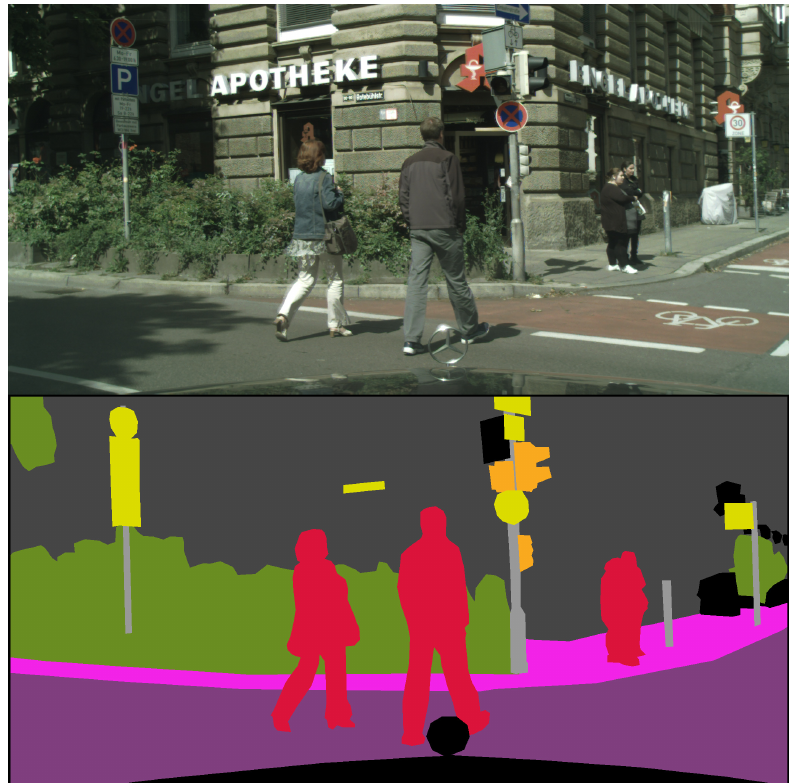
Figure 4. Street view with people but no